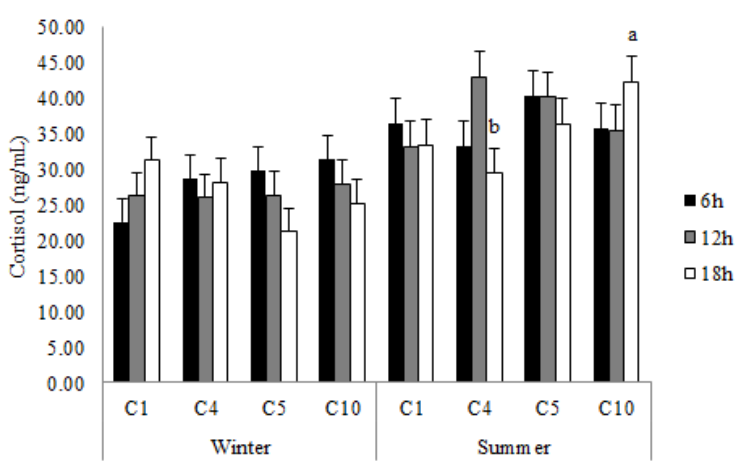
Figure 3. Blood cortisol value (LSM ± SEM) in pigs transported for 6, 12 and 18 h in the compartments C1, C4, C5 and C10 during winter and summer. a,b Least squares means without a common superscript differ ( p < 0.05).